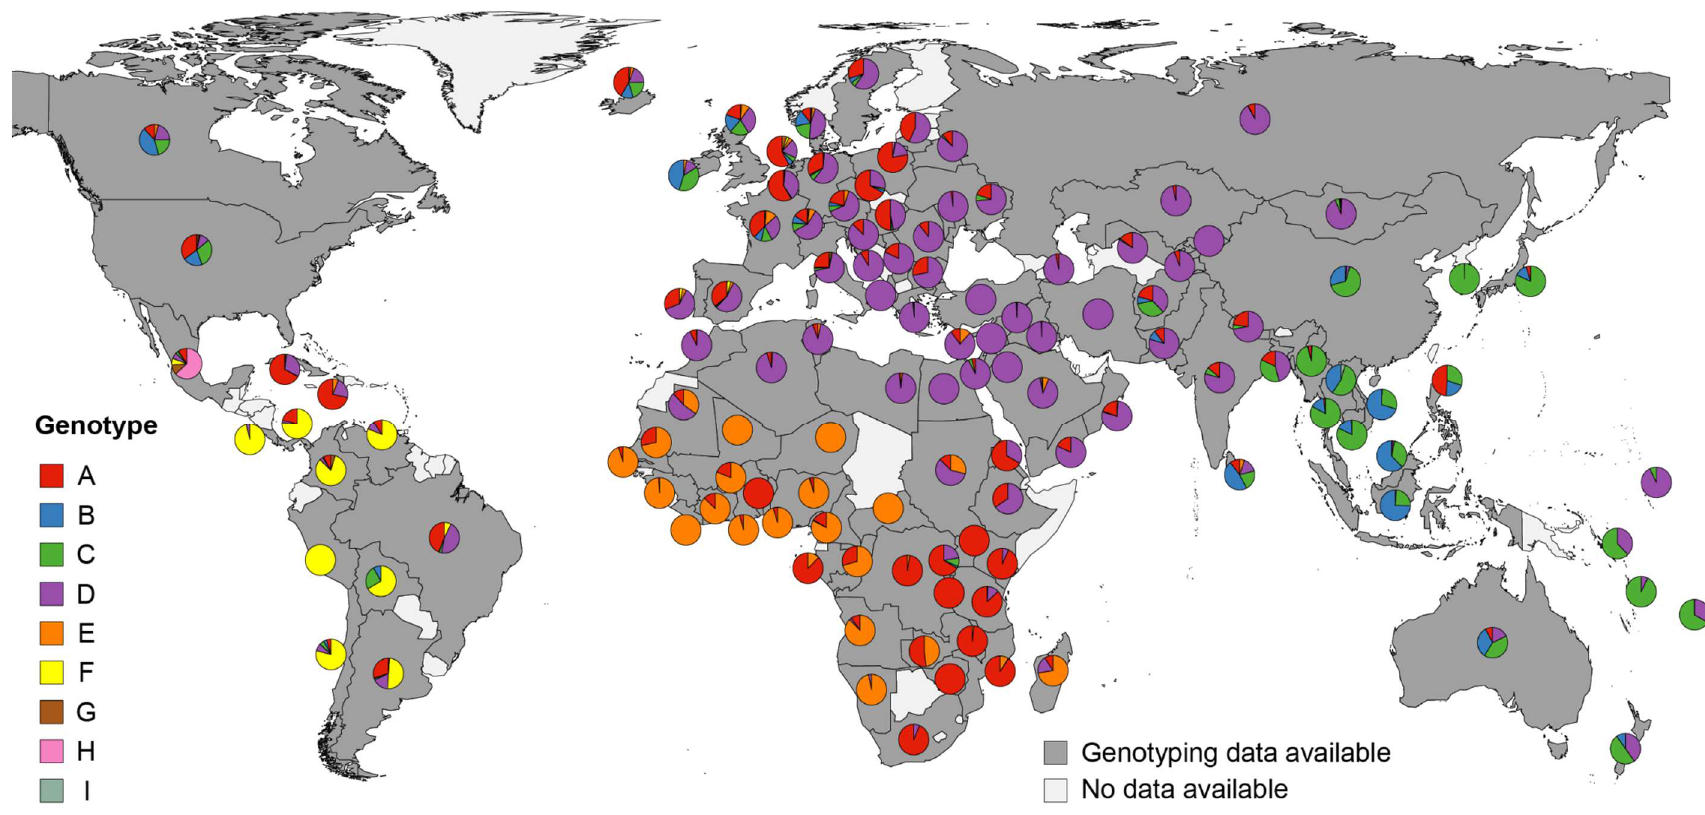
Figure 3. Distribution of HBV genotypes by country. Pie charts indicate proportional HBV genotype distributions in the respective countries. Genotype distributions within samples with successful genotyping are presented, excluding inter-genotype recombinant viruses, co-infections with more than one HBV genotype or undefined infections. Underlying literature sources and number of sequenced isolates are given in Table S1 (Supplementary Materials).